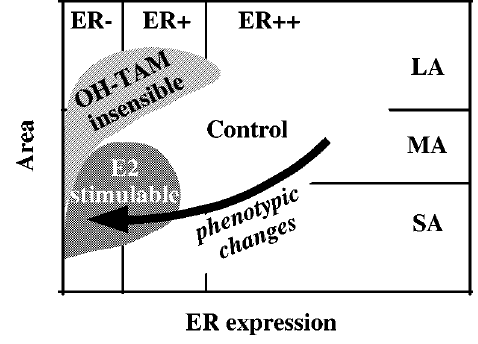
Fig. 10. Diagram showing the remodeling of MCF-7 cell subpopula- tions under estrogenic (E2) and antiestrogenic (OH-TAM) treatment. hydroxytamoxifen-resistant cell lines such as MCF-7 LY2, MCF-7 LCC1 and MCF-7 LCC2 [24]. It